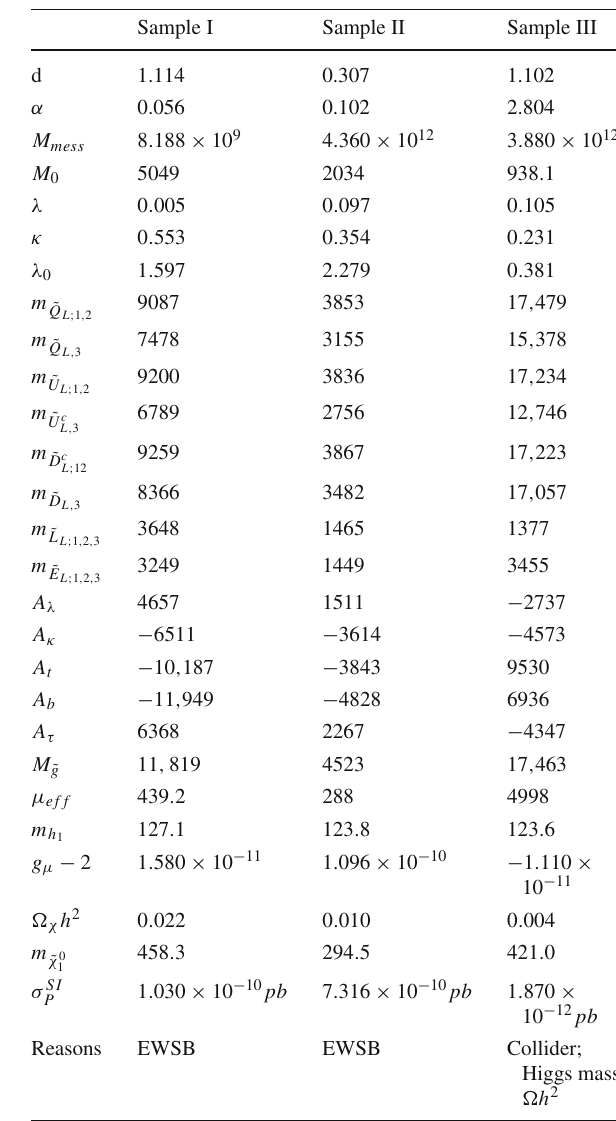
Table 1 Benchmark points, which should not survive the various con- straints if the gauge-modulus interference contribution is absent. The quantities with mass dimension are in unit of GeV. Without the gauge- modulus interference contribution, the points will not survive the con- straints because of the constraints shown in ‘ Reasons ’